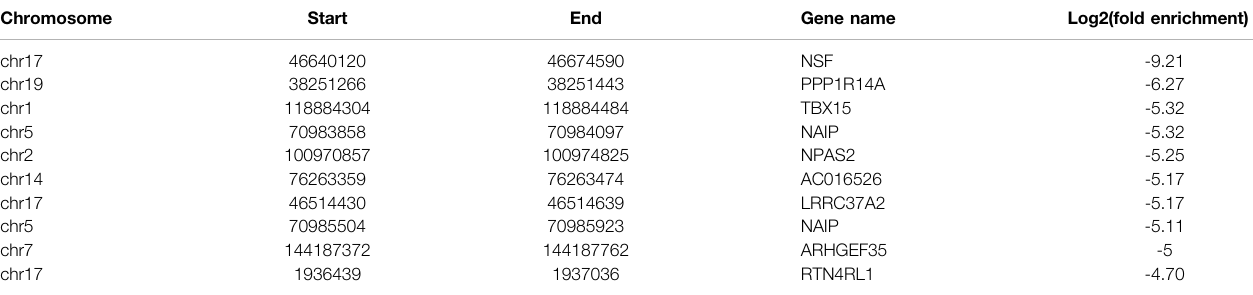
TABLE 3 | Top ten down-regulated methylated m 6 A-modi fi ed RNAs.